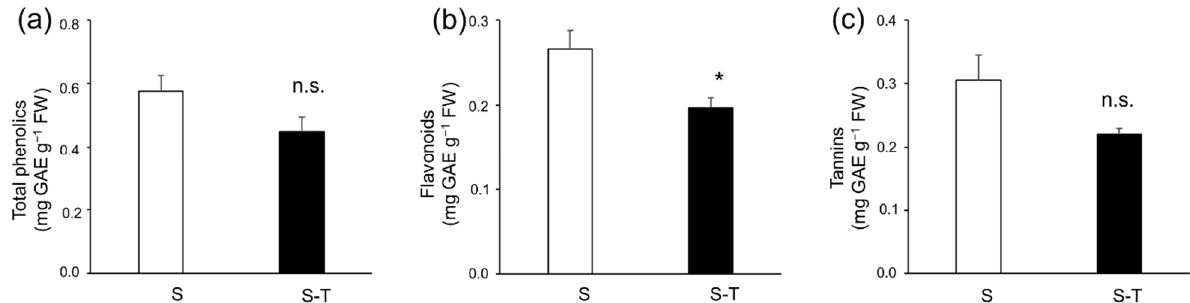
Figure 3. Concentration of ( a ) total phenolics, ( b ) flavonoids, and ( c ) tannins of the edible portion of Salicornia plants cultivated in monoculture (S) or in intercropping with tomato plants (S-T). Data represent the mean ± SE ( n = 4). Significance level: * p ≤ 0.05; n.s. = not significant.